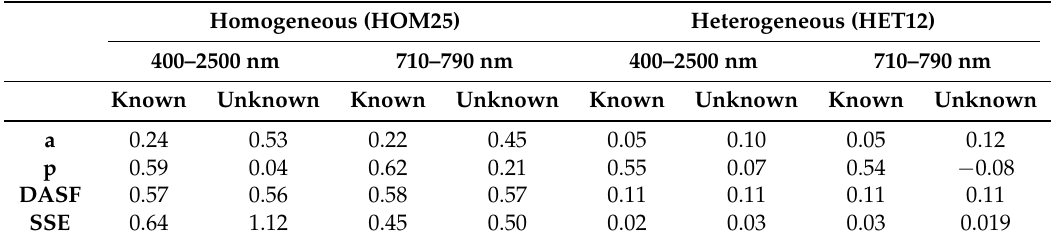
Figure 3. a , p and DASF parameters extracted via both Lewis and Disney [14]’s and Knyazikhin et al. [5]’s models. Table 2. Spectral invariants parameters a and p , DASF and SSE for known and unknown ω using both full and 710–790 nm spectral region in HOM25 and HET12 canopies.